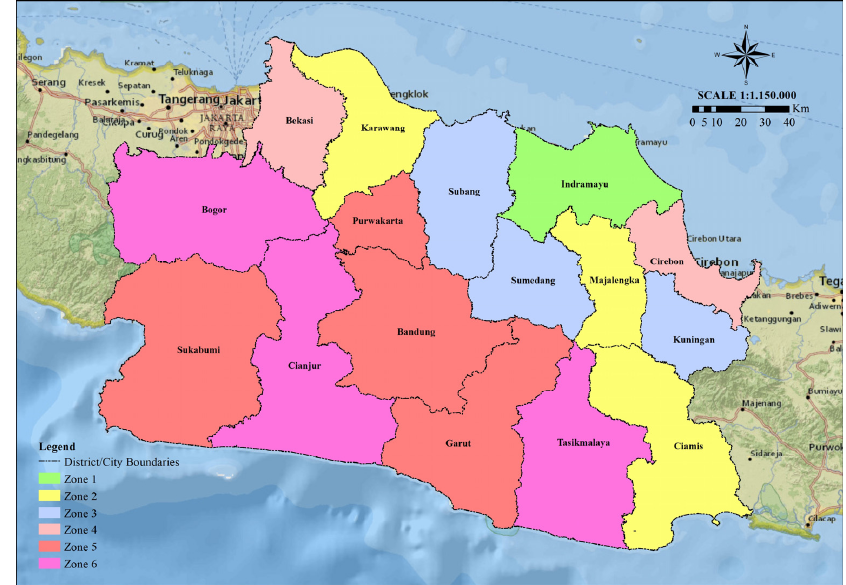
Figure 12. The results of dividing the zones of West Java Province use clustering of type II